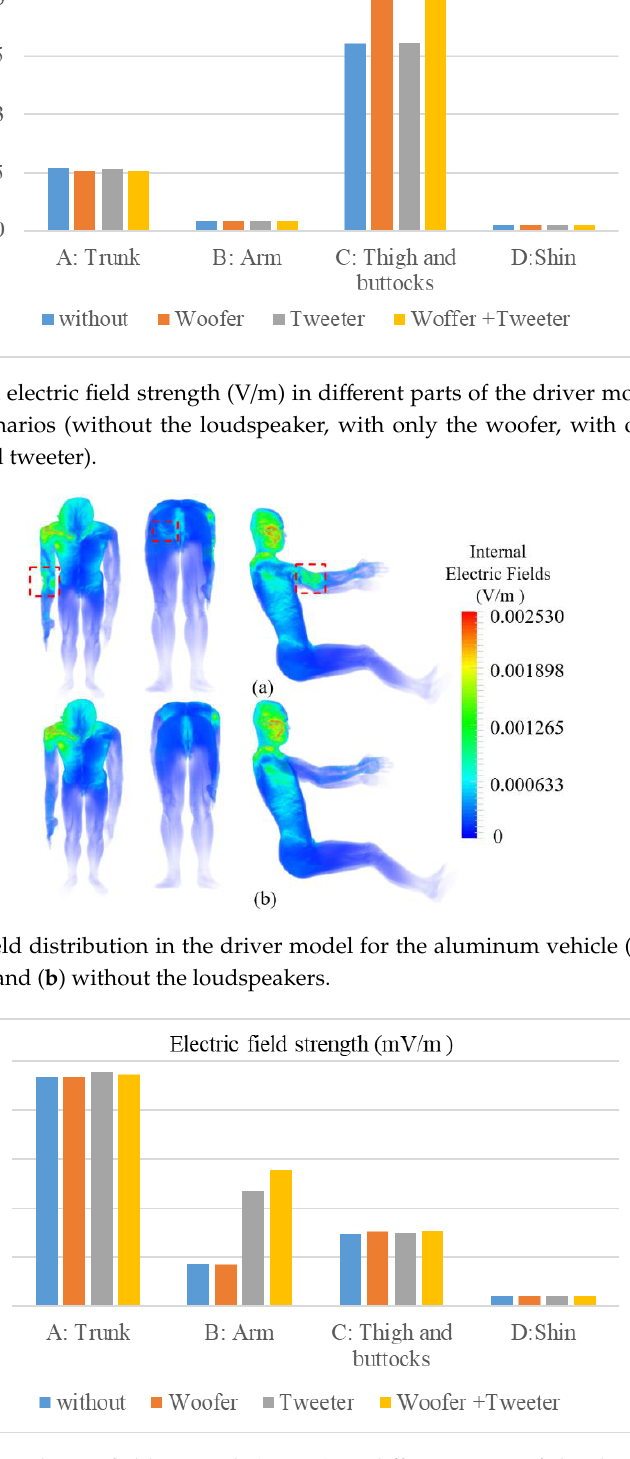
Figure 10. Maximum electric field strength (mV/m) in different parts of the driver model in the aluminum vehicle for four scenarios (without the loudspeaker, with only the woofer, with only the tweeter, and with woofer and tweeter).